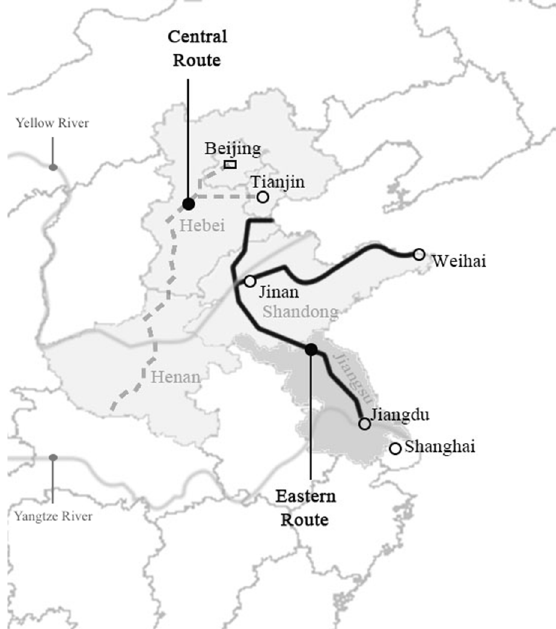
Figure 1. Map of the study